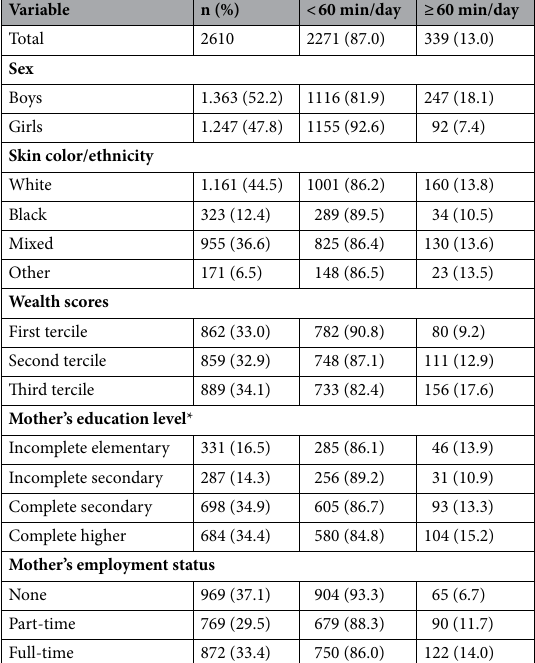
Table 1. Characteristics of adolescents by total physical activity level (< 60 min/day vs ≥ 60 min/day). SP-PROSO, São Paulo, 2017. *The maternal education variable had substantial missing data (n =